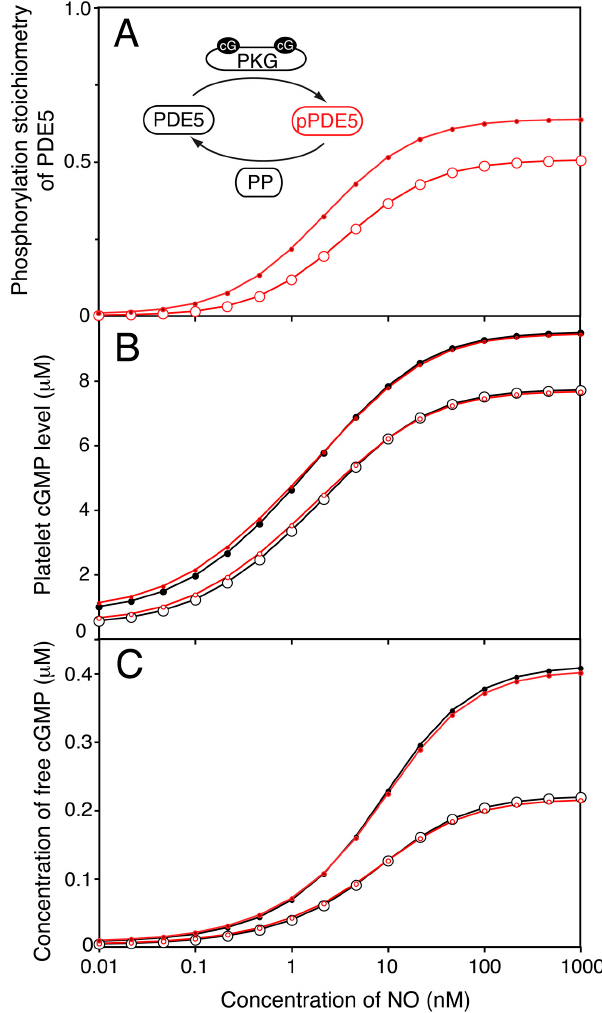
Figure 3. Effect of PKG mediated phosphorylation of PDE5 on cGMP response to NO.